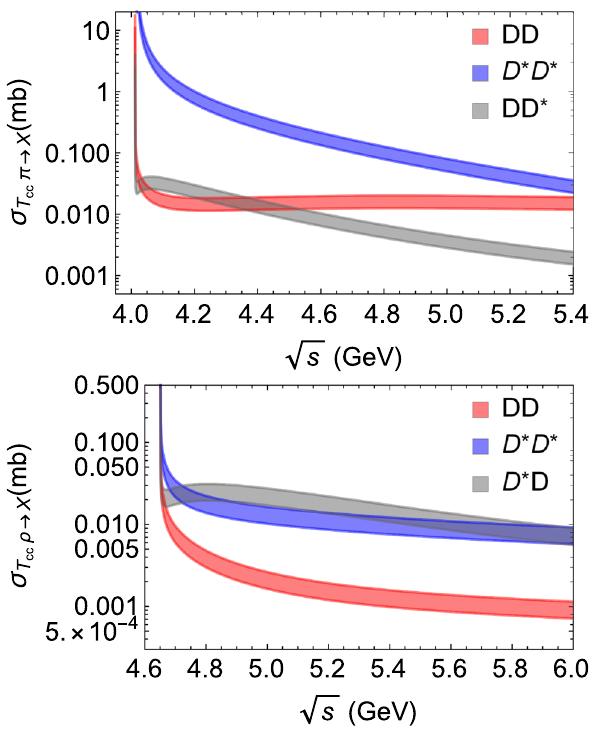
Fig. 5 CrosssectionsasfunctionsoftheCMenergy tion processes D ( ∗ ) D ( ∗ ) → T + cc π (top panel) and D ( ∗ ) D ( ∗ ) → T + cc ρ (bottom panel), taking the form factors obtained within the QCDSR